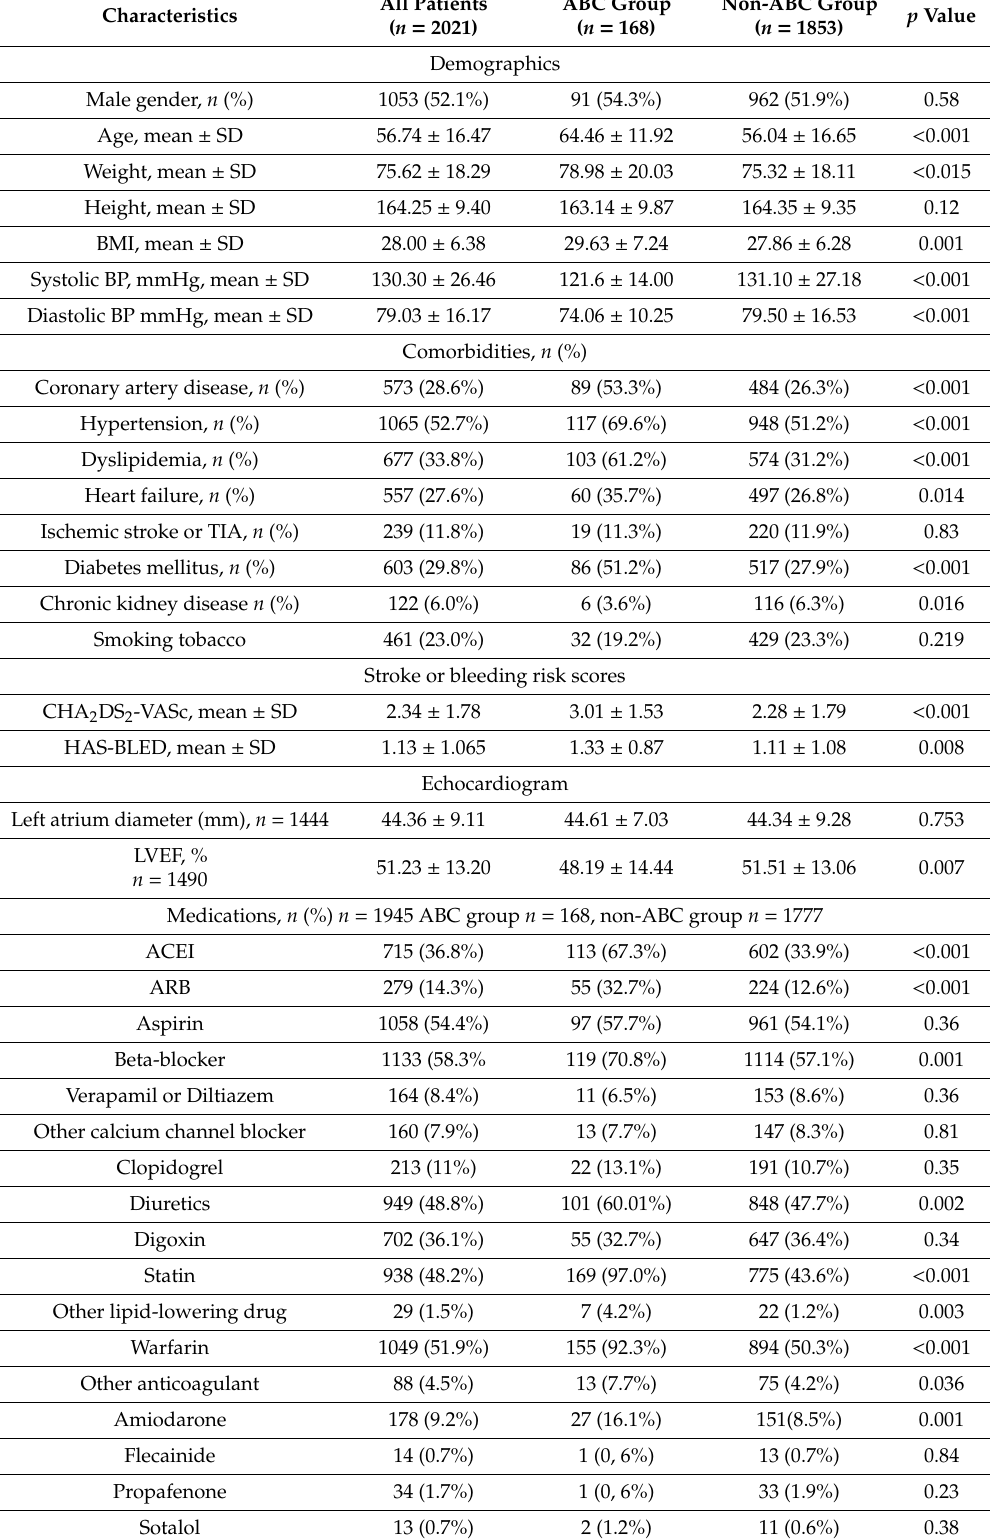
Table 1. Baseline characteristics of patients according to adherence to ABC